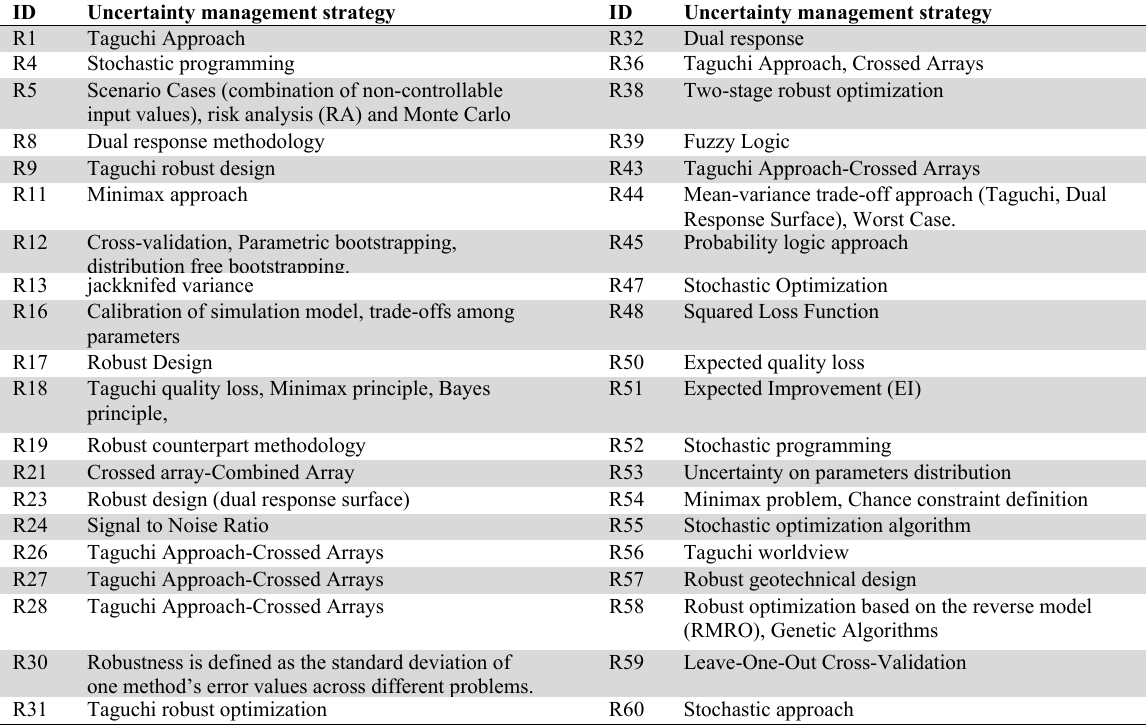
Applied different strategies in literature for management of